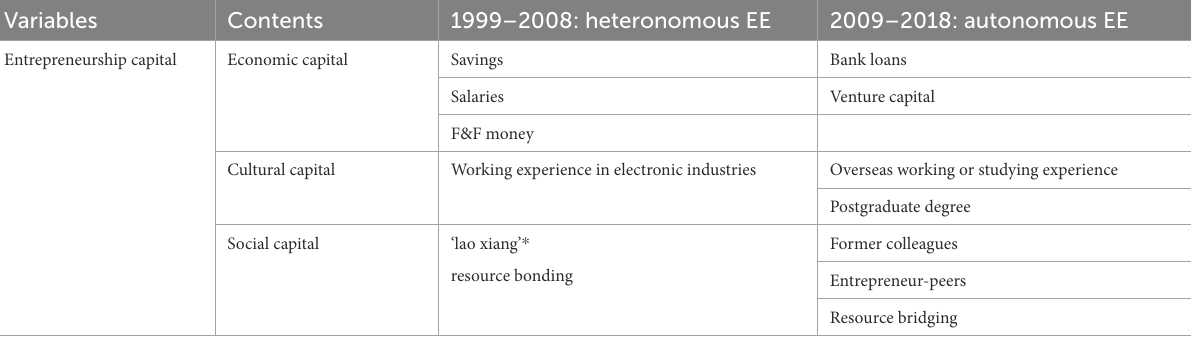
TABLE 1 Entrepreneurship capital components from Shenzhen entrepreneurs’